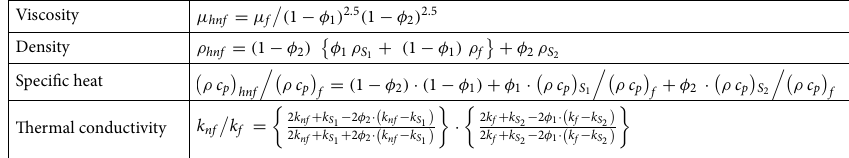
Table 2. Thermo-physical traits of TiO 2